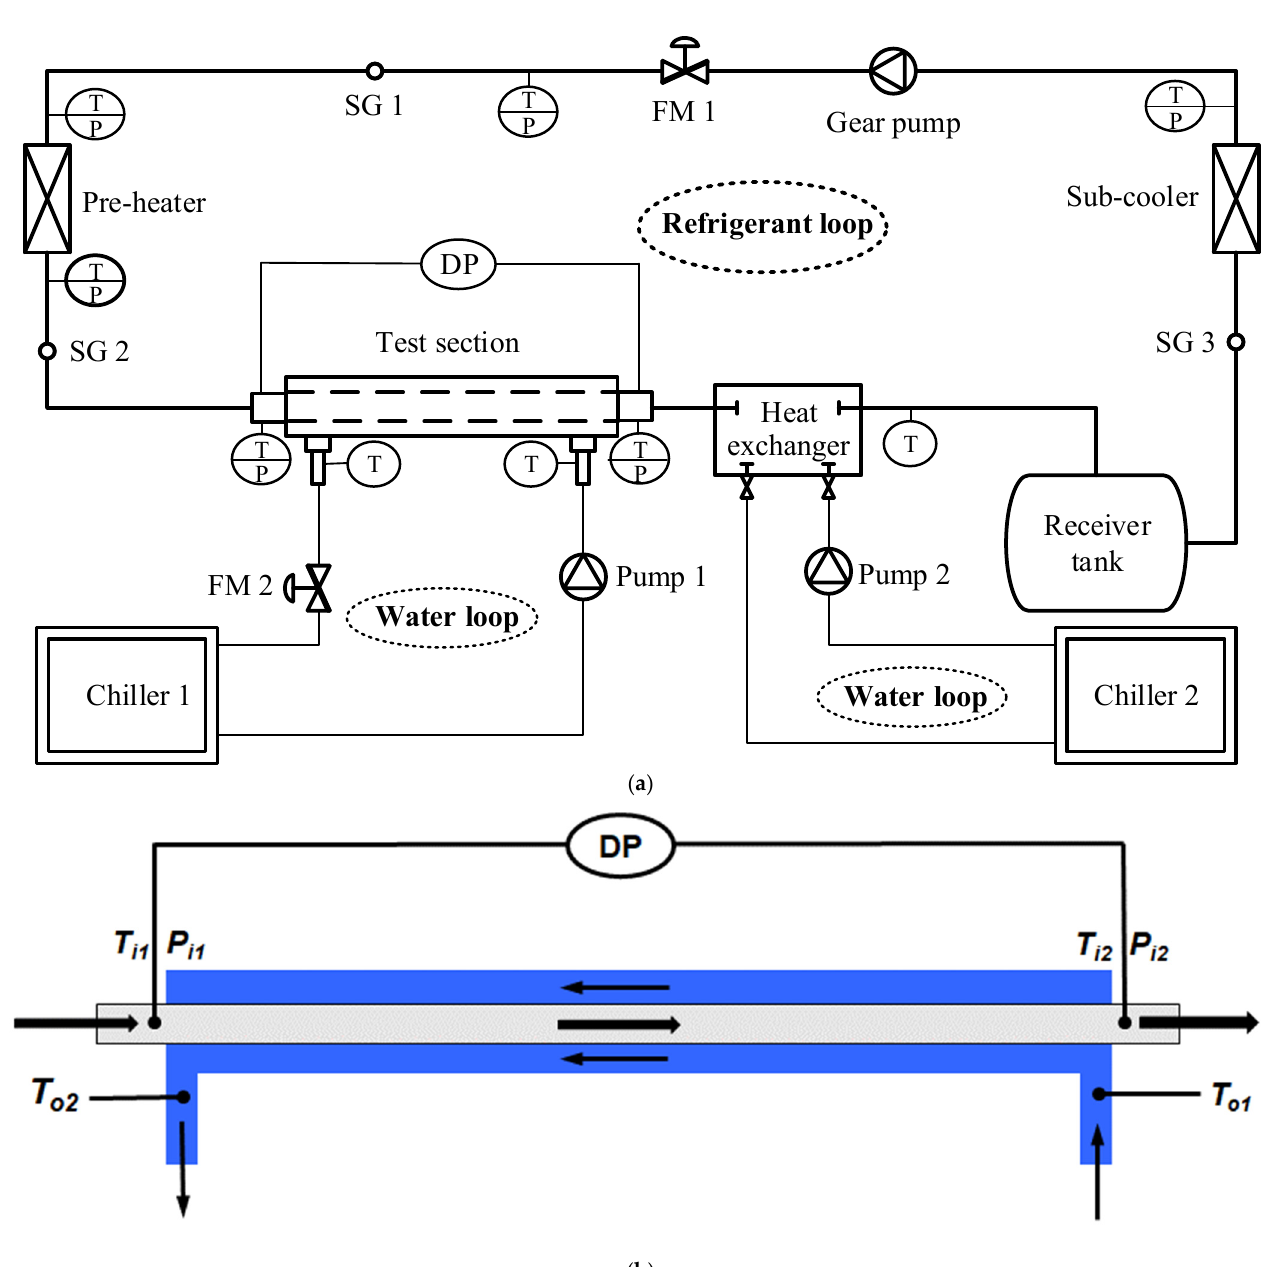
Machines 2021 , 9 , x FOR PEER REVIEW